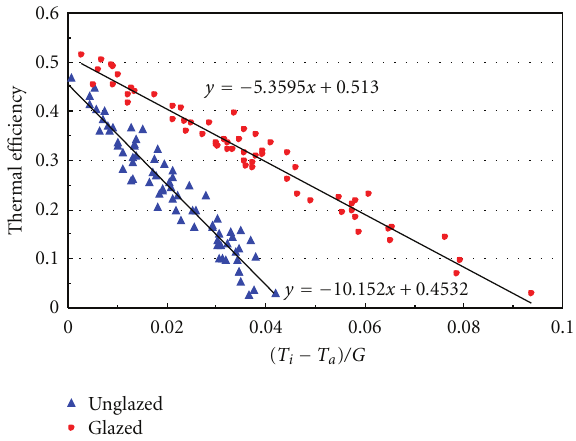
Figure 5: View of PVT collector (a) evaluated in the experiment and performance measurement equipment for the PVT collector (b).